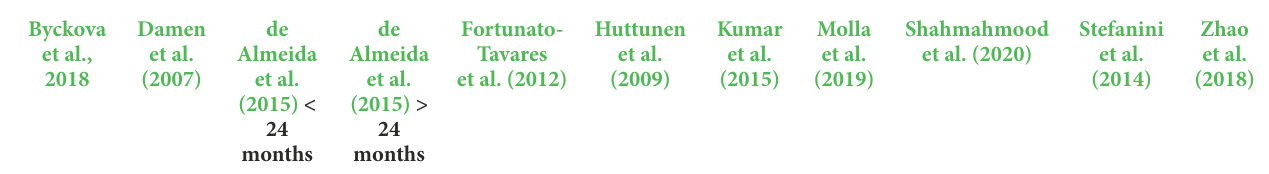
TABLE 5 Self-reliance subscale Tukey HSD post-hoc mean